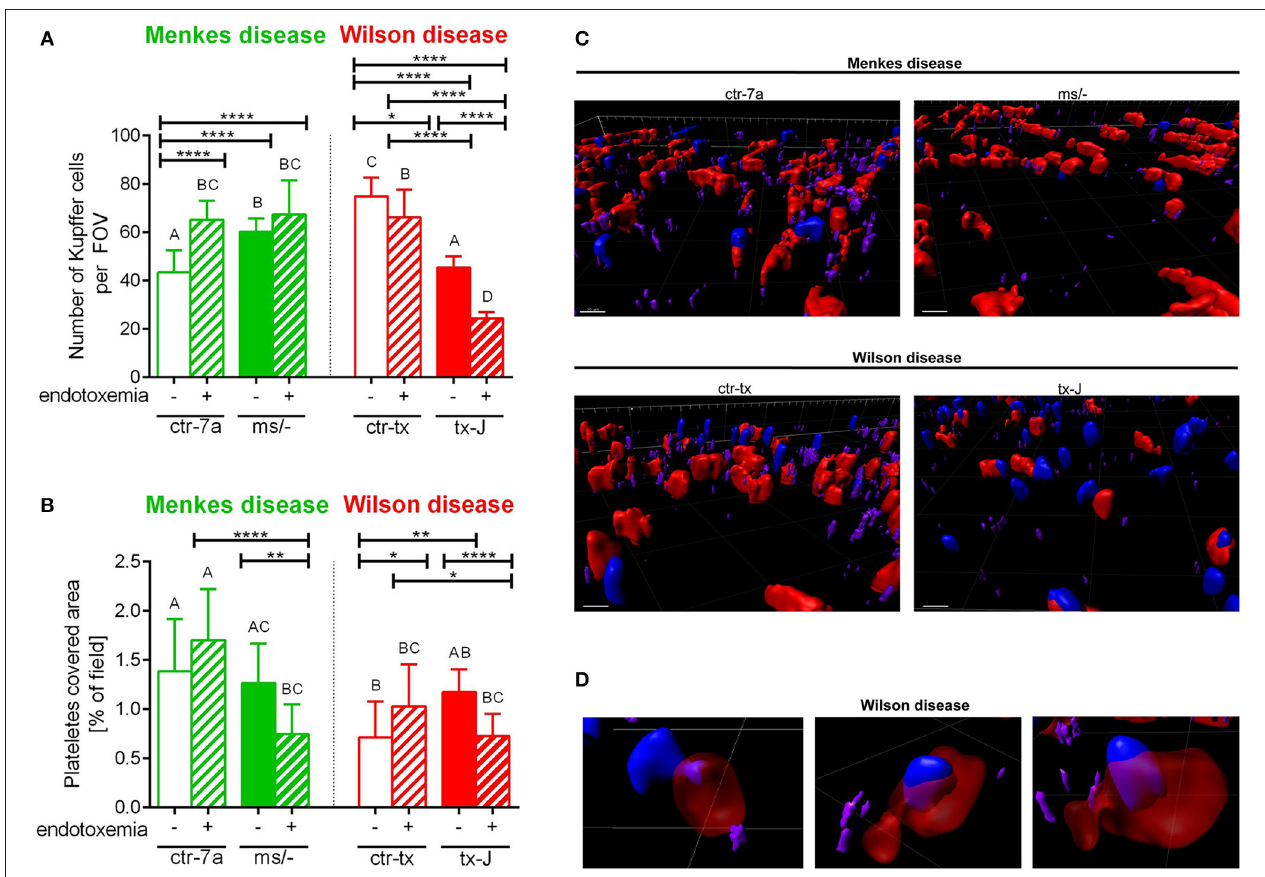
FIGURE 4 | The presence of Kupffer cells (A) and platelets (B) in livers of Wilson (tx-J) and Menkes ( ms / − ) disease mice and their respective controls (ctr-tx and ctr-7a) with endotoxemia. Kupffer cells were counted per field of view (FOV), and area covered by platelets is expressed in percentage (as calculated by ImageJ) (mice n = 3/group). Asterisks indicate significant differences using unpaired two-tailed Student’s t test (* P ≤ 0.05, ** P ≤ 0.01, **** P ≤ 0.0001) and one-way ANOVA ( post hoc Bonferroni) test (different letters indicate statistically significant differences between groups). A series of optical cross-sections ( z stacks) were made through inflamed livers. Exemplary images of z stacks made through the liver of Menkes disease and Wilson disease mice and their respective controls are shown in (C) . Kupffer cells are marked in red, neutrophils in blue, and neutrophil elastase in violet. In endotoxemic mice with Wilson disease, neutrophils present (partially or fully) inside some Kupffer cells were observed (D) . The scale bar indicates 20 µ